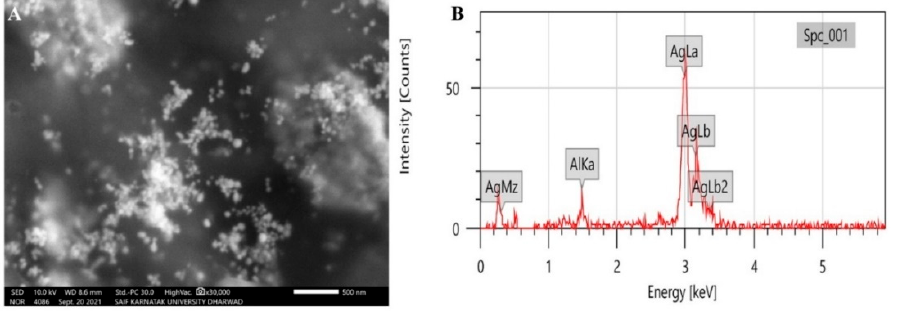
Figure 5. SEM with EDX analysis of synthesized P-AgNPs from P. alba leaf extract ( A ) SEM image showing surface morphology, ( B ) EDX spectrum indicating the presence of silver.